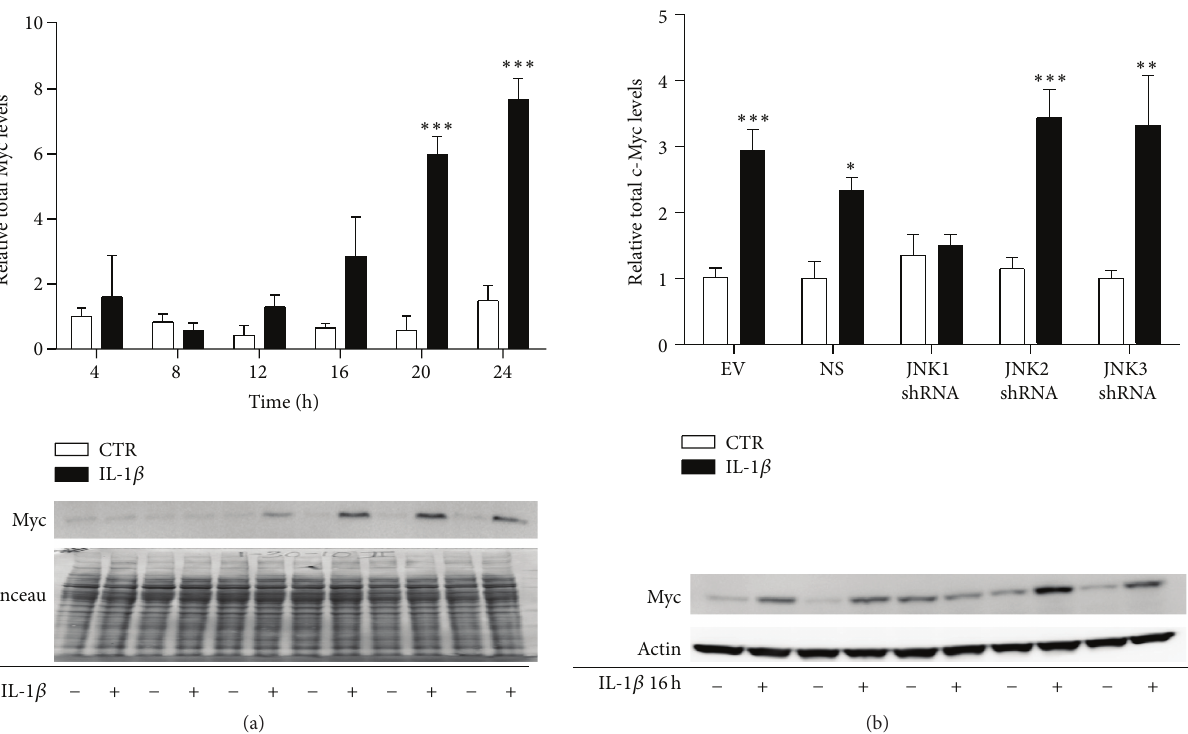
Figure 6: JNK1 knockdown prevents the regulation of total Myc protein by IL-1 𝛽 . INS-1 cells were exposed to 150 pg/mL IL-1 𝛽 (closed bars) or vehicle (open bars) for 4 to 24 h. Protein was isolated and (a) total Myc protein levels were analyzed by immunoblotting. Total protein was used as the loading control. Data are shown ± SEM of 𝑛 = 3 - 4 independent experiments. INS-1 cells stably expressing shRNA directed against JNK1, JNK2, JNK3, or the nonsense or empty vector controls were exposed to 150 pg/mL IL-1 𝛽 (black bars) or left unexposed (white bars) for 16h. Protein was isolated, and (b) total Myc protein levels were analyzed by immunoblotting. Actin was used as the loading control. Data are shown ± SEM of 𝑛 = 5 independent experiments. ∗∗ 𝑃 < 0.01 and ∗∗∗ 𝑃 < 0.001 comparing Myc levels in the presence with Myc levels in the absence of IL-1 𝛽 , unless otherwise